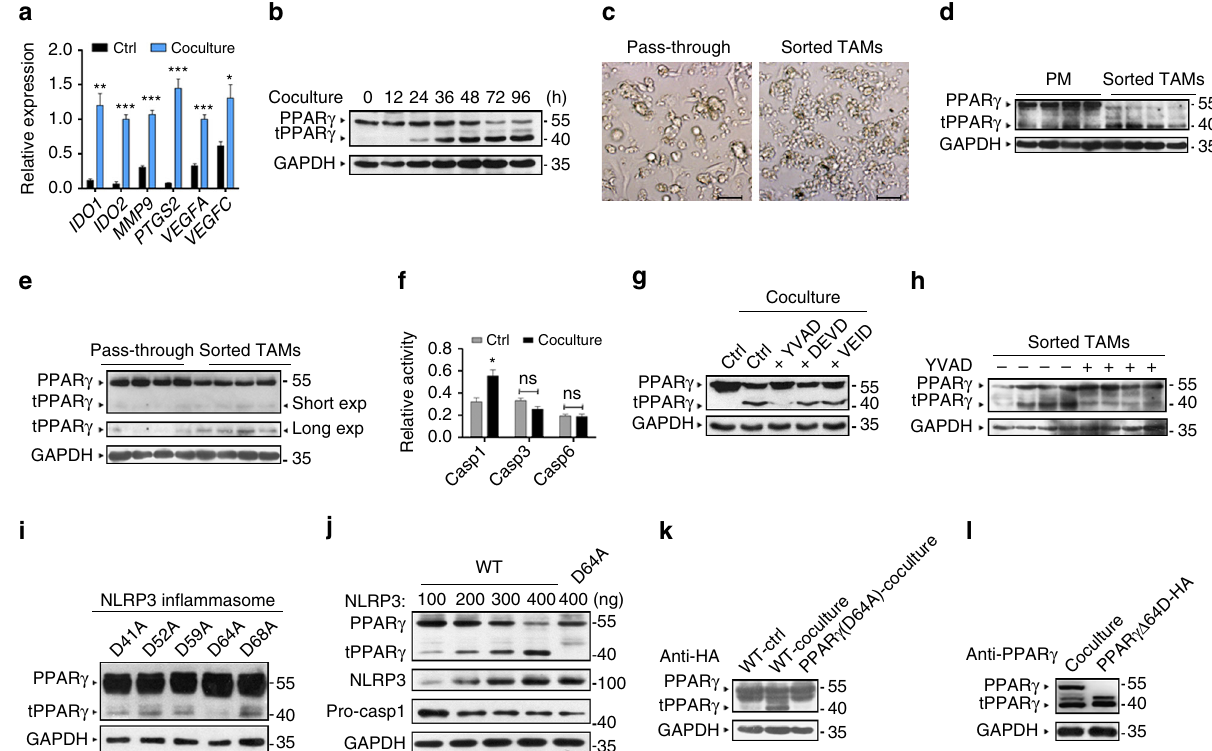
Fig. 1 Caspase-1 mediates PPAR γ cleavage in TAMs in vitro and in vivo. a THP-1 macrophages were cultured alone or cocultured with MCF-7 for 48 h, the expression of protumoral genes was assessed by RT-qPCR (n = 6). b Cocultured THP-1 cells were harvested at indicated time, PPAR γ and its truncated fragment (tPPAR γ ) were determined by immunoblot. The expression levels of proteins in this fi gure were all determined by immunoblot, except a , c and f . c Cell morphology of sorted TAMs and pass-through cells (mainly tumor cells) from MMTV-PyMT mice. Scale bars, 100 μ m. d , e PPAR γ and tPPAR γ in TAMs from MMTV-PyMT mice ( d ), or 4T1 orthotopic-grafted mice ( e ) were shown, using peritoneal macrophages (PM) ( d ) or pass-through cells ( e ) as the control. TAMs in each different lane sample was pooled from at least two mice (the same in i ). f THP-1 macrophages were cultured alone or cocultured with MCF-7 for 24 h, then the relative activity of caspase-1, caspase-3, or caspase-6 was tested ( n = 3). All statistic data represent means ± s.e. m., (* P < 0.05, ** < 0.01, *** < 0.001, ns, not signi fi cant, on way ANOVA for multiple comparisons). g THP-1 macrophages were cultured alone or cocultured with MCF-7 in the presence or absence of caspase inhibitors for 48 h, PPAR γ and tPPAR γ were shown here. h PPAR γ and tPPAR γ in sorted TAMs from MMTV-PyMT mice administration of vehicle or caspase-1 inhibitor YVAD, were determined by immunoblot. i , j The levels of PPAR γ and tPPAR γ were shown in HEK293T cells ( i ), which were transfected with different PPAR γ mutant plasmids as indicated and in fl ammasome associated plasmids (NLRP3 300 ng, pro-caspase-1 20 ng and ASC 20 ng) for 24 h ( i ), or HEK293T cells ( j ), which were transfected with PPAR γ or PPAR γ (D64A) plasmids together with plasmids for in fl ammasome with increasing doses for NLRP3 (100 to 400 ng). k Extracts of THP-1 cells transfected with HA-PPAR γ plasmids were cultured alone or cocultured with MCF-7 for 48 h and extracts of THP-1 cells transfected with HA-PPAR γ (D64A) plasmids cocultured with MCF-7 for 48 h were determined by immunoblot. l PPAR γ in extracts of THP-1 macrophages cocultured with MCF-7 for 48 h, and HEK293T cells transfected with HA-PPAR γΔ 64D plasmids were